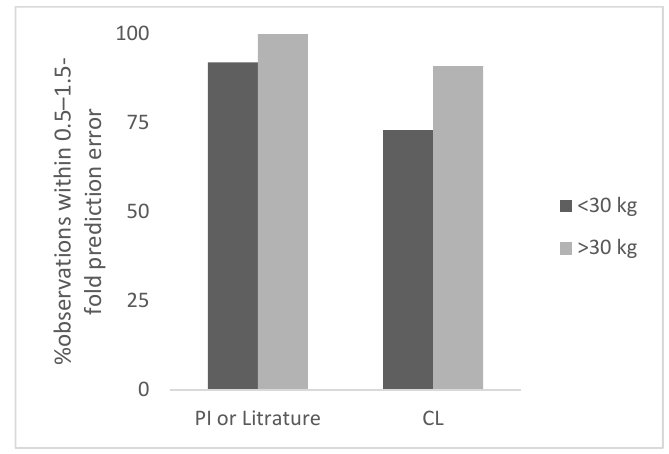
Figure 4. Percent observation within 0.5–1.5 ‐ fold prediction error for non ‐ antibodies.